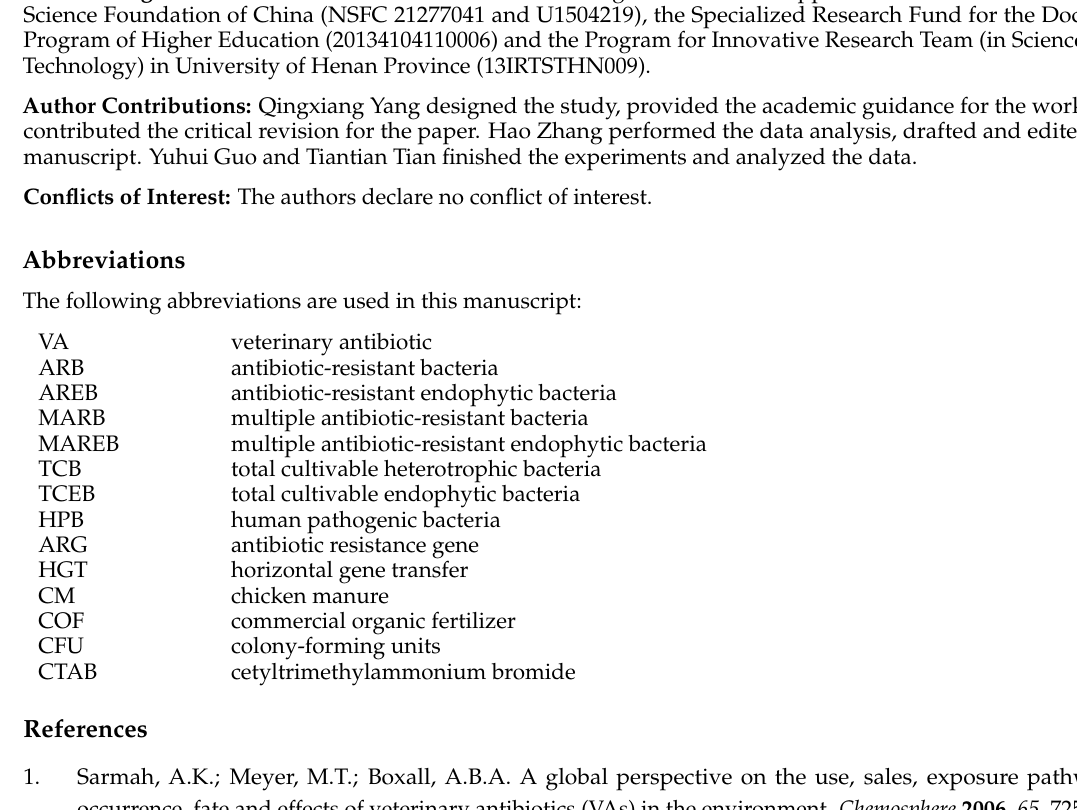
Figure S1: Phylogenetic analysis of MARB and MAREB isolated from the control soil and pakchoi; Figure S2: Phylogenetic analysis of MARB and MAREB isolated from the CM-amended soil and pakchoi; Figure S3: Phylogenetic analysis of MARB and MAREB isolated from the COF-amended soil and